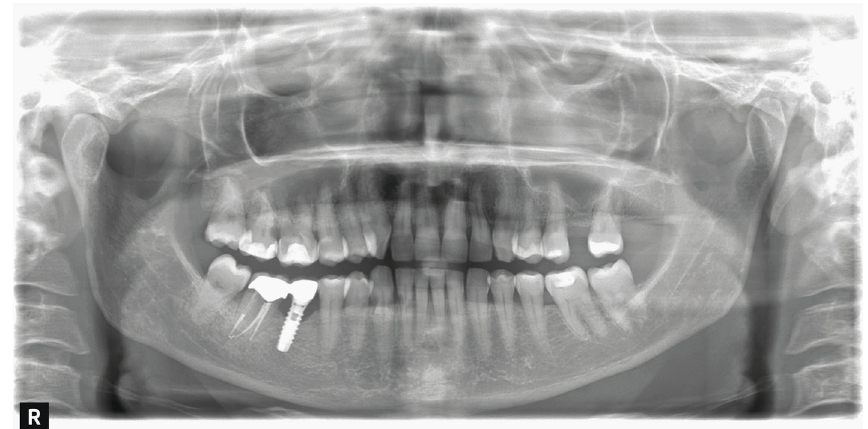
Figure 1: Implant 4.6 with initial signs of peri-implantitis.